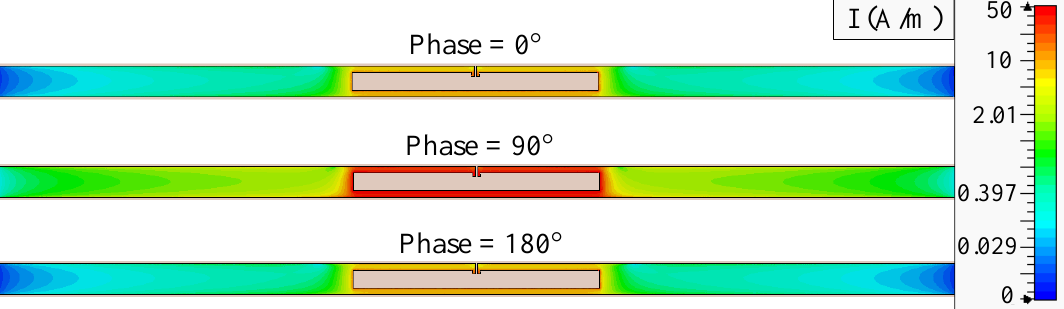
Figure 9. Simulated surface current magnitude plot of the antenna at 0 ◦ , 90 ◦ , and 180 ◦ at 915 MHz.